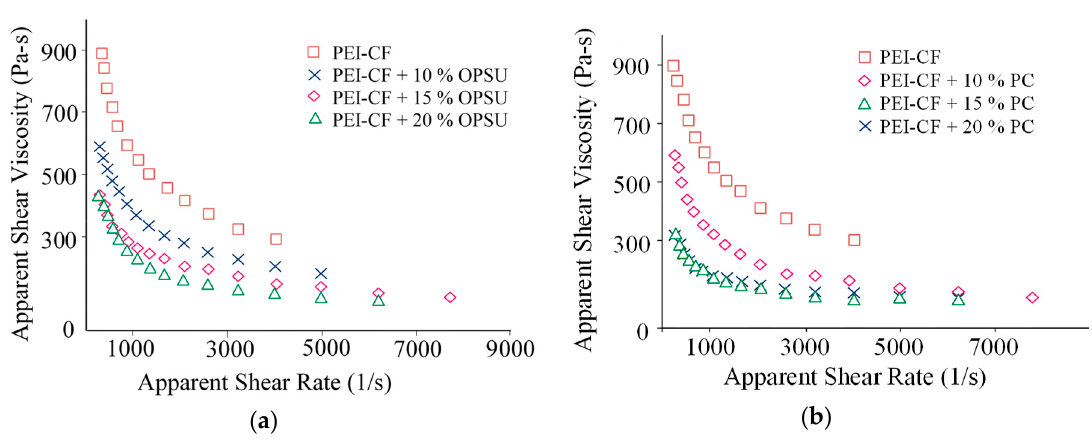
Figure 7. Dependence of the PEI-CF melt viscosity on the content of OPSU ( a ) and PC ( b ).